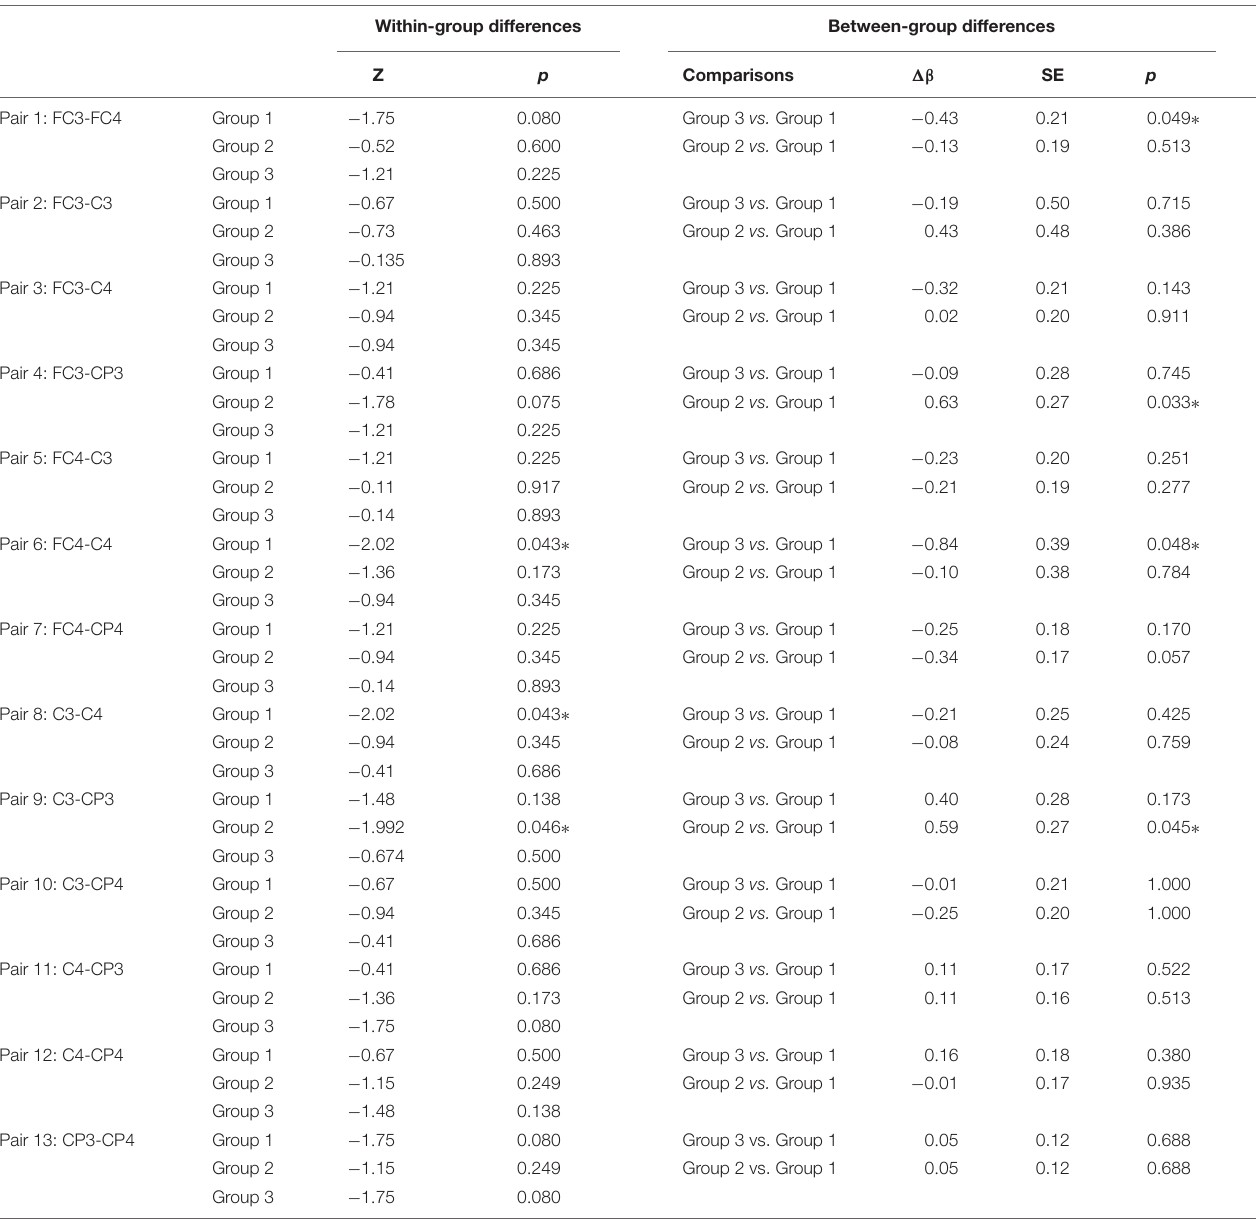
TABLE 1 | Results of coherence differences across three groups.